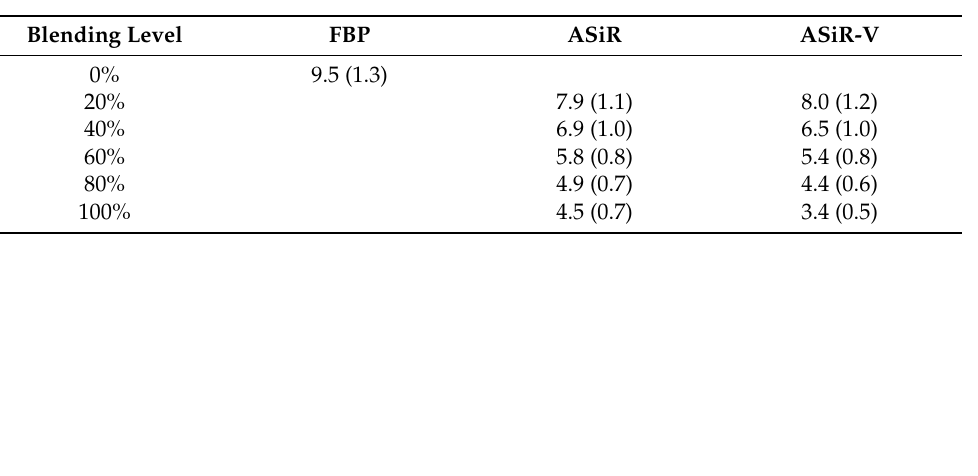
Table 2. Homogeneous CTP486 module. Noise level estimated as the mean (SD) value of N-FBP, N-ASiR, and N-ASiR-V maps within a central circular ROI of 1 cm